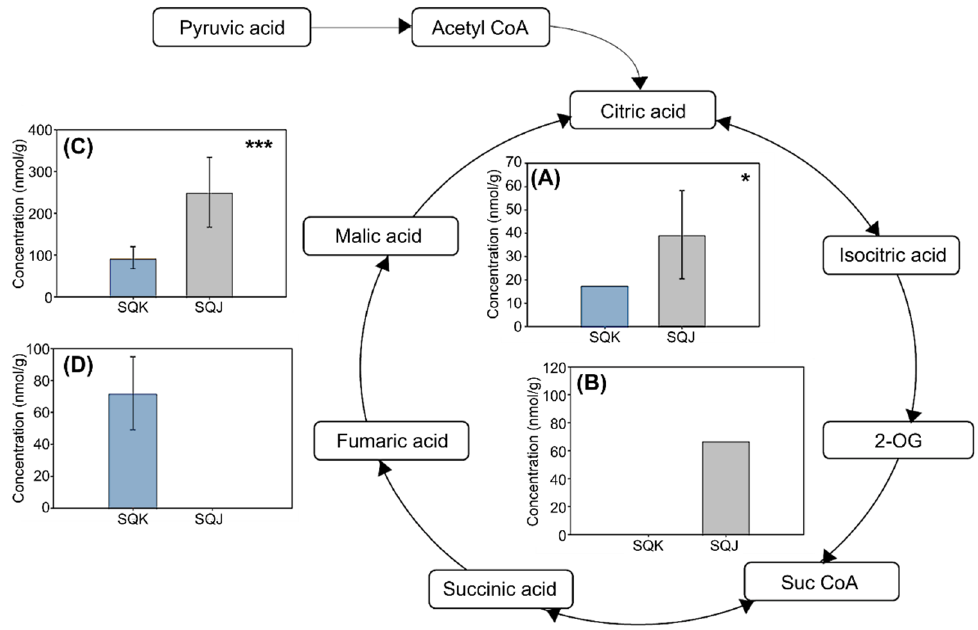
Figure 3. Different metabolite compounds in the TCA cycle: ( A ) citric acid. ( B ) 2-oxaloglutaric acid, ( C ) fumaric acid, and ( D ) malic acid. For each plot, blue bar = SQK and gray bar = SQJ. Error bars represent standard deviation. Significant differences were calculated using Welch’s test (* < 0.05, *** < 0.001).